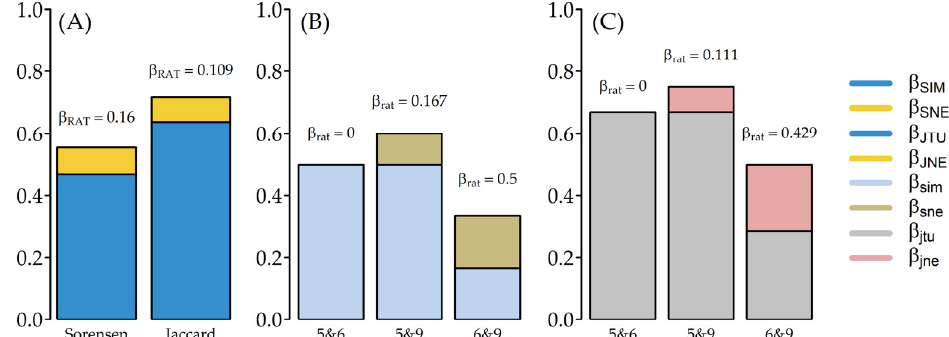
Figure 5. Beta diversity partitioning at ( A ) the multisite level using the Sørensen index with turnover ( β SIM ) and nestedness ( β SNE ) and the Jaccard index with turnover ( β JTU ) and nestedness ( β JNE ); ( B ) Sørensen pairwise level with turnover ( β sim ) and nestedness ( β sne ); ( C ) Jaccard pairwise level with turnover ( β jtu ) and nestedness ( β jne ). The values of β RAT and β rat were calculated as the ratio of nestedness to the total nestedness plus turnover. The pairwise comparison label format, e.g., 5&6 = five-year-old plantation compared to six-year-old